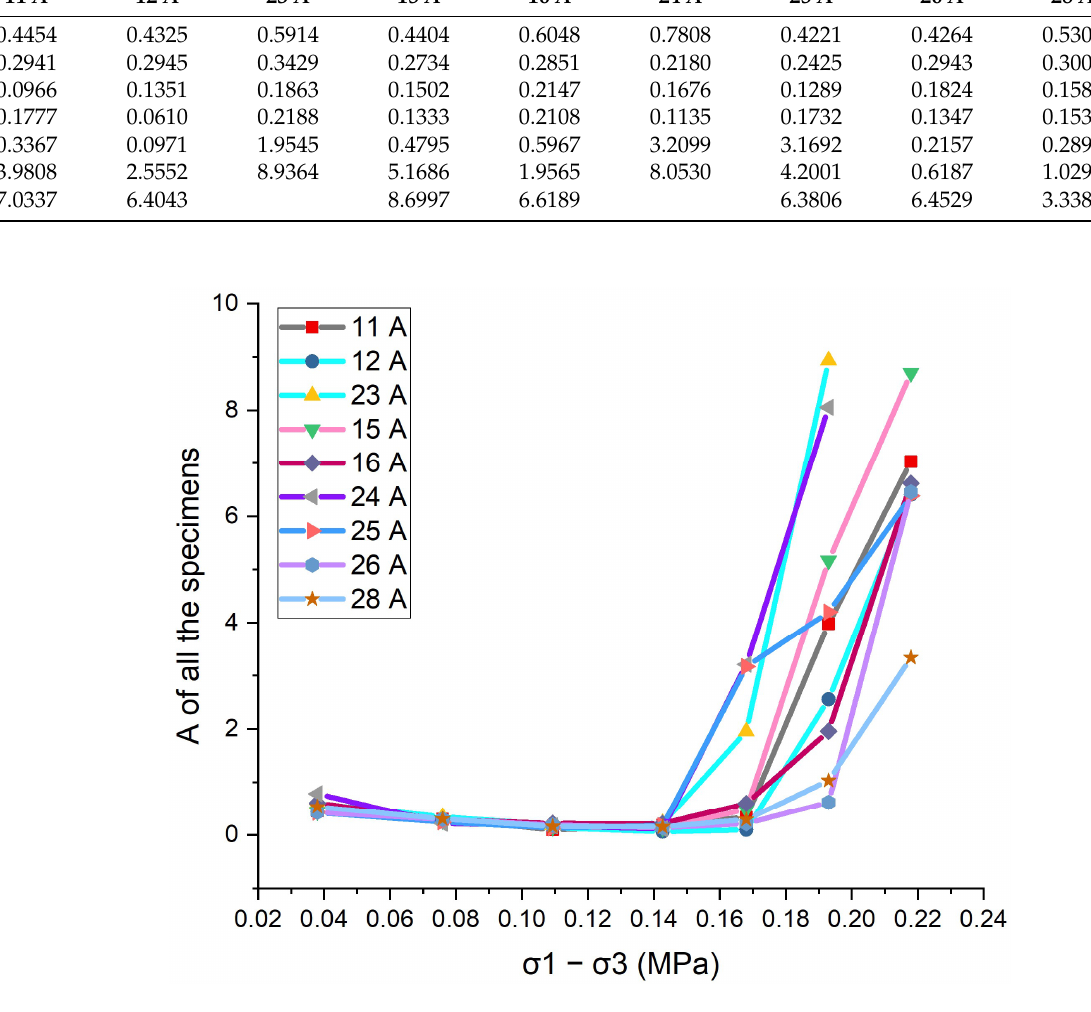
) of all the spec- − 𝜎 (cid:2869) (cid:2871)